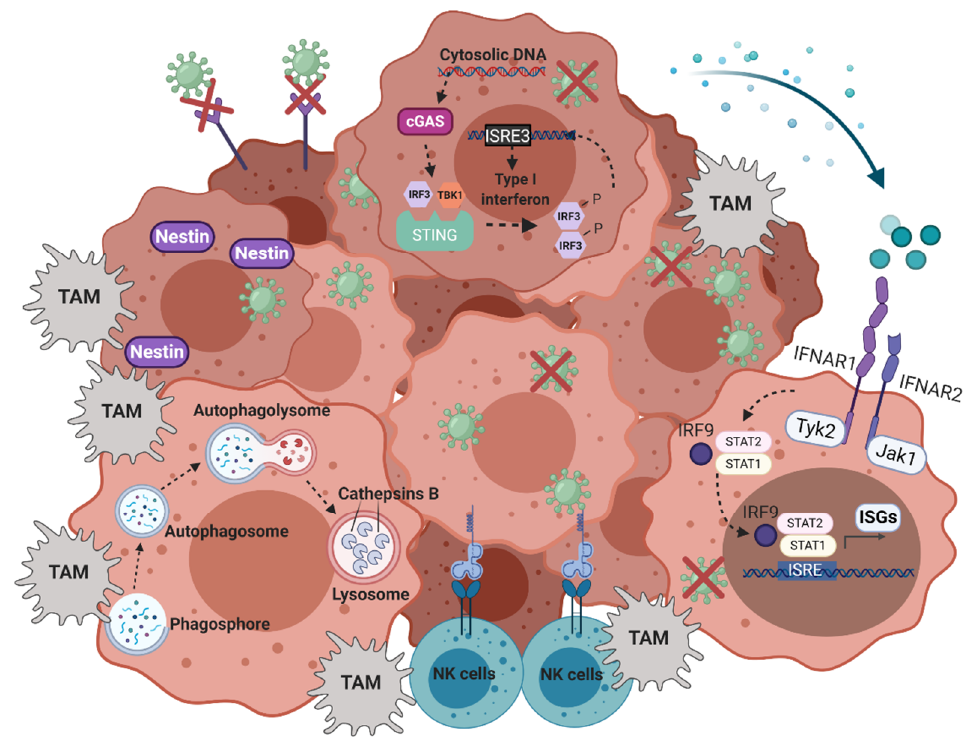
Figure 1. OV restriction mechanisms of GBM tumors. Infiltration of NK cells and tumor-associated macrophages (TAMs) at the tumor site, activation status of autophagy, expression of viral entry molecules and viral sensors (e.g., cGAS-STING) that lead to constitutive active type I interferon pathways, all could hamper the OV replication and oncolysis. Furthermore, cathepsin B expression and expression of specific proteins that drive specific tumor replication (e.g., nestin) could determine the OV efficacy. Created with BioRender.com.